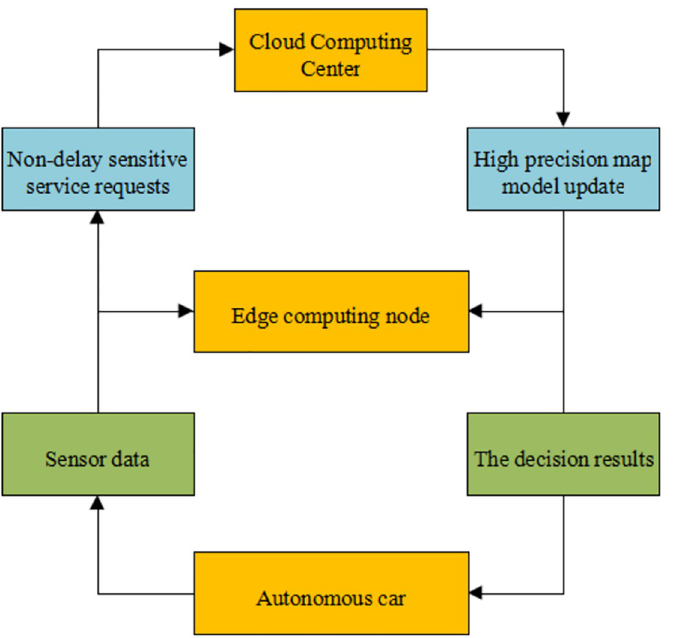
Fig 3. Architecture of autonomous vehicles based on edge